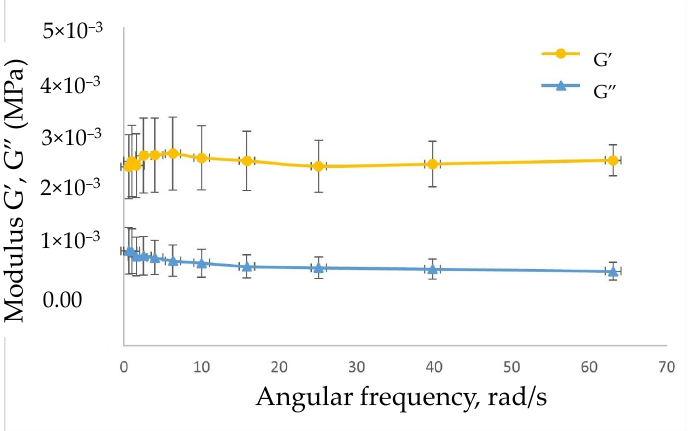
Figure 12. Effect of frequency sweep on the elastic (G’) and viscous (G”) moduli of water-swollen PSt- l -GG-5 10 wt%. See ‘Materials and Methods’ for test conditions. Surface morphology was studied by scanning electron microscopy (SEM), Figure 13.